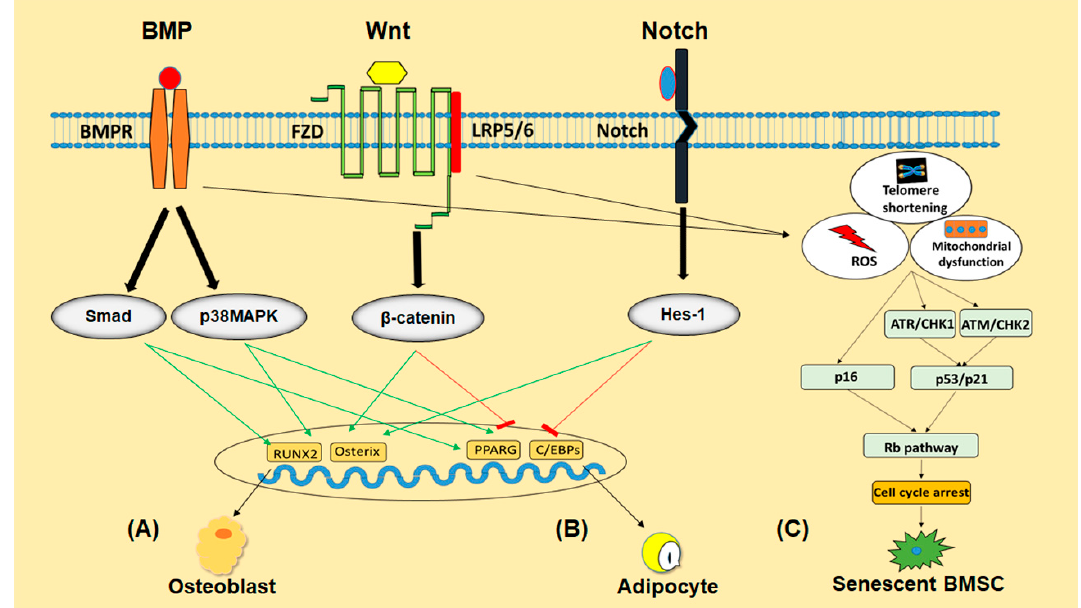
Figure 2. The schematic program of signaling pathways involved in regulating differentiation and senescence of BMSCs. BMP, Wnt and Notch signaling pathways regulate BMSCs differentiation into osteoblast ( A ) or adipocyte ( B ) either by promoting or inhibiting their respective transcriptional factors. Telomeres shortening, accumulation of ROS or mitochondrial damage activate p53/p21 and p16/Rb pathways in BMSCs to push them into senescence ( C ).